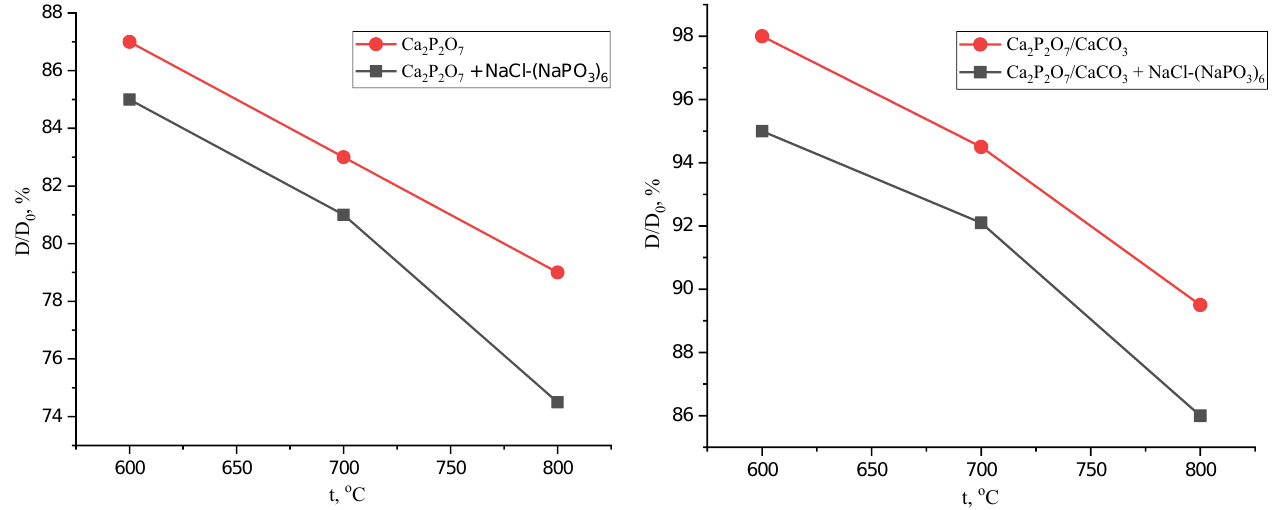
Figure 7. Dependences of the relative diameter of the ceramic CPP (Ca 2 P 2 O 7 ) and CPP/CC (Ca 2 P 2 O 7 /CaCO 3 ) samples prepared with or without the use of the additive on the firing tempera- ture.